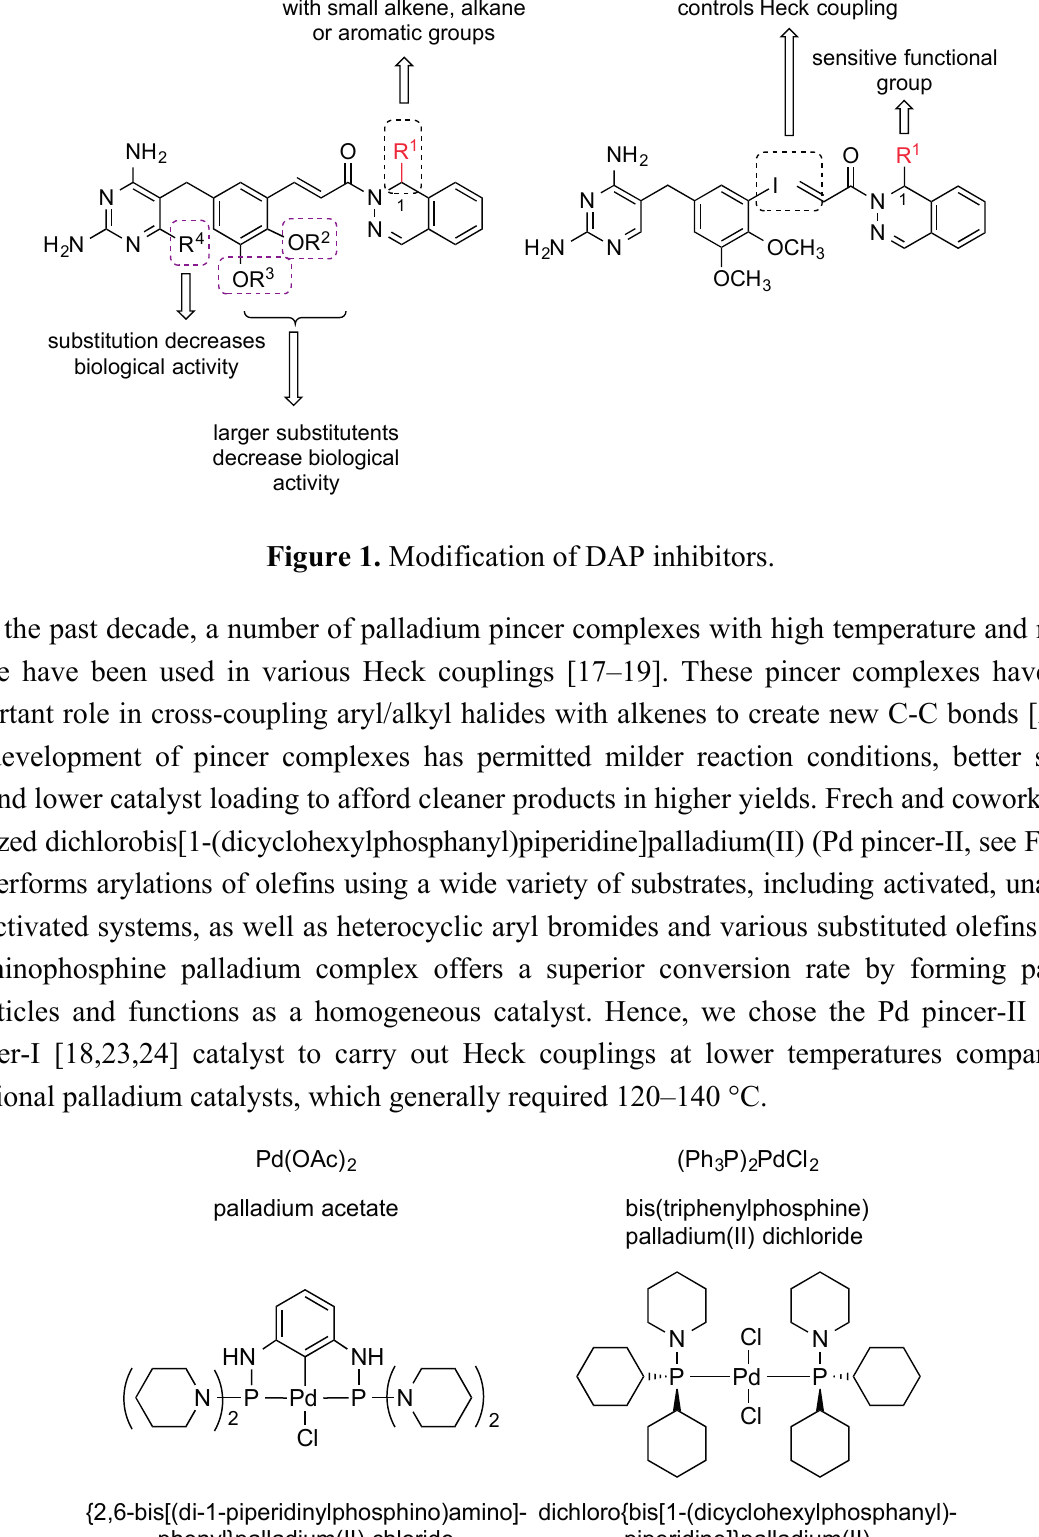
Figure 2. Pd catalysts for Heck